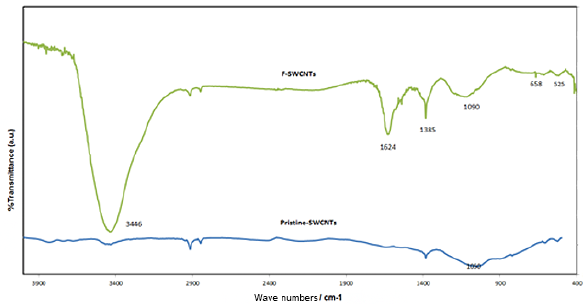
Figure 3. FTIR spectra of pristine and sulfonated